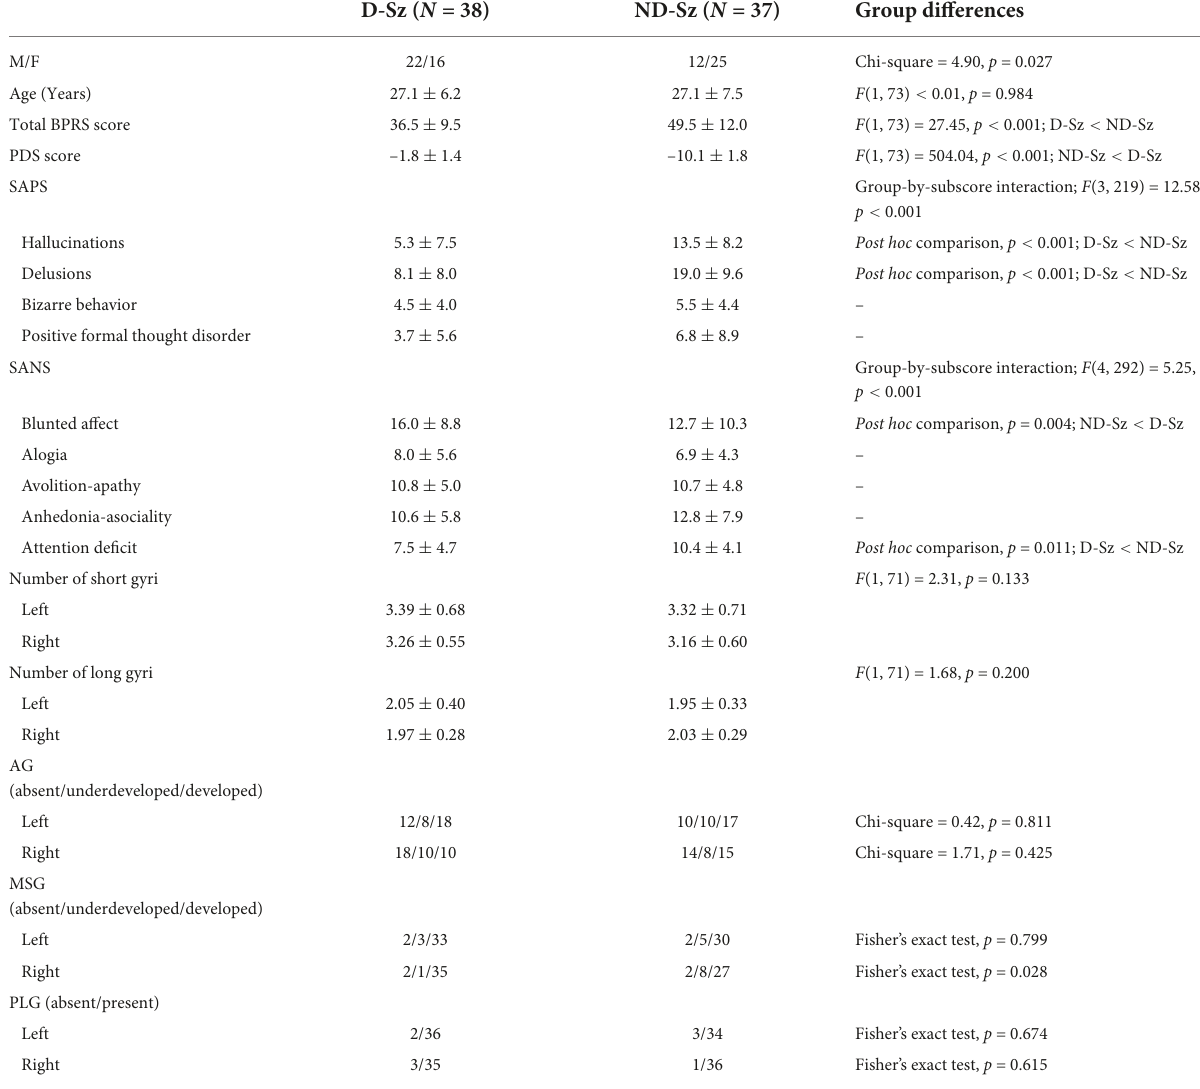
TABLE 3 Sample characteristics and gross insular morphology of deficit and non-deficit subtypes of